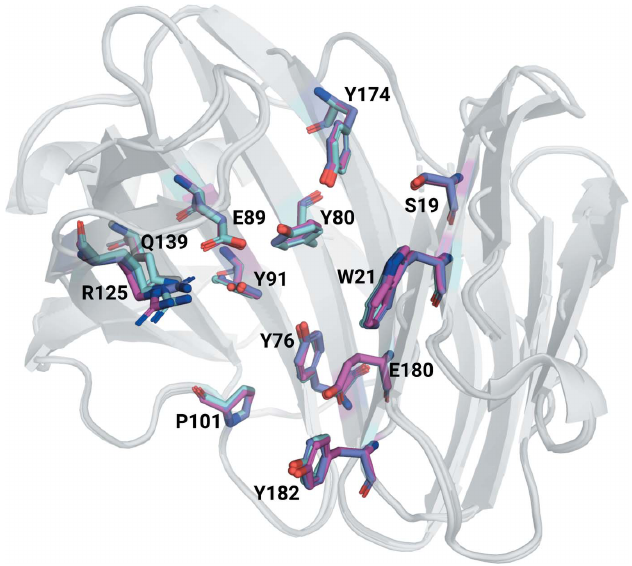
Figure 8 Detailed view of the alignment of all residues composing the active site of NhGH11 xylanase. The cryoMX residues are shown in cyan, the full 40000-image dataset structure are shown in magenta and additionally the active site residues from the structure obtained by refinement against the 1000-image dataset are shown in purple. The strongest deviations from the cryoMX reference can be observed in Arg125, all other residues overlap almost